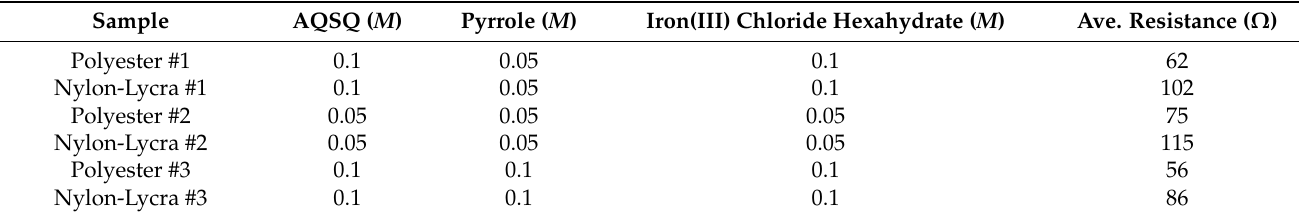
Table 3. Resistance values of coated fabrics with plasma pre-treatment.